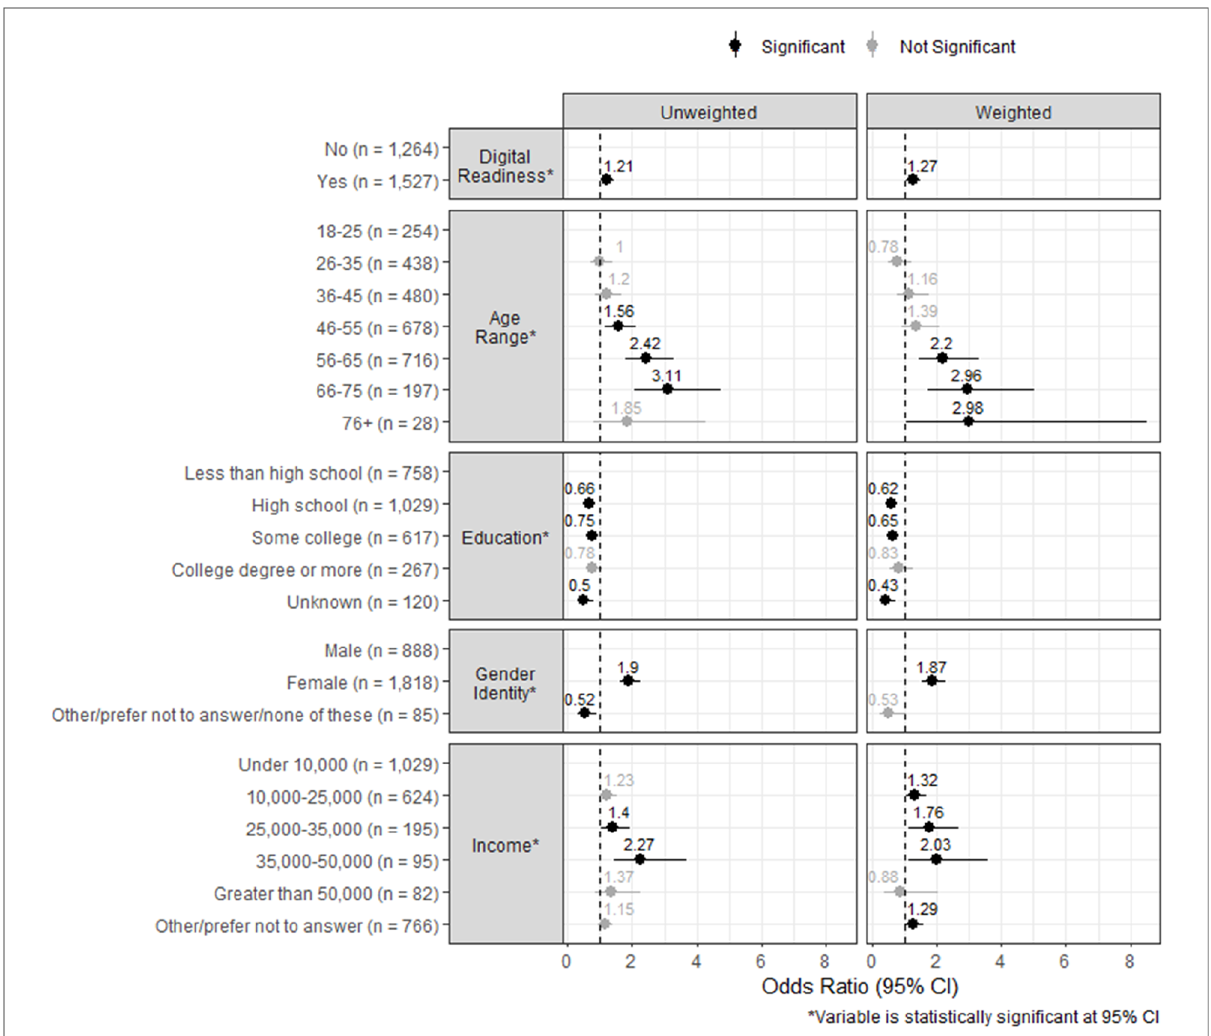
FIGURE 3 Results from weighted and unweighted models to understand the impact of digital readiness on retaining participants at FQHCs. (Outcome variable: Retention Status. Coded as 1 if the participant was retained, and 0 if the participant was never retained. Retained participants complete follow-up surveys on a web-based portal at least once every 18 months after their enrollment, indicating sustained engagement after recruitment to the